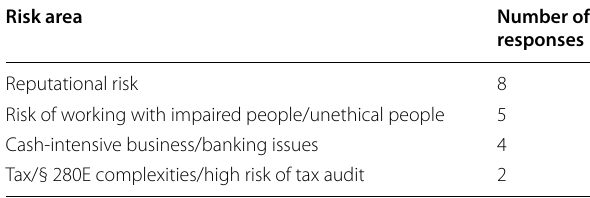
Table 4 Other potential risk areas reported by participants